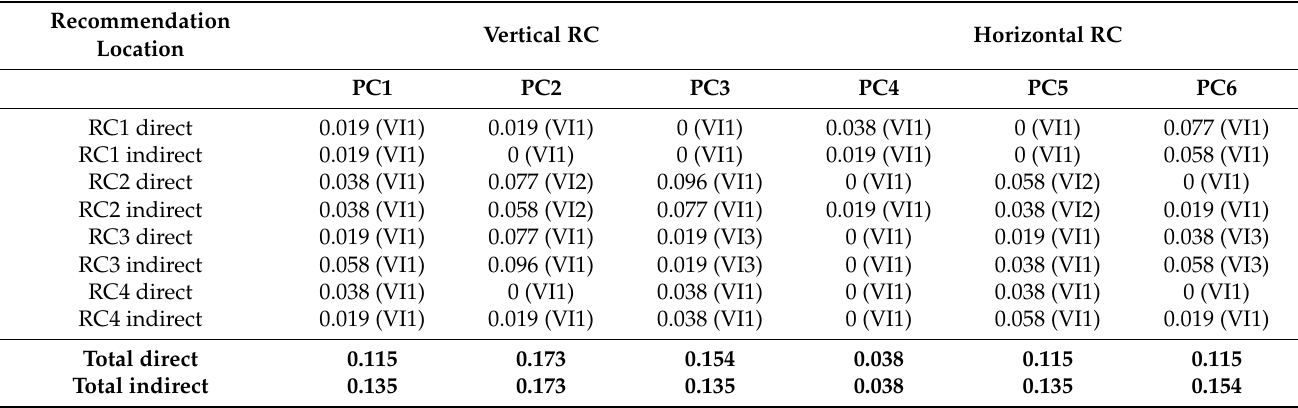
Table 6. Recommendation-driven purchase and visual intensity for each recommendation location RC i and product category PC j .